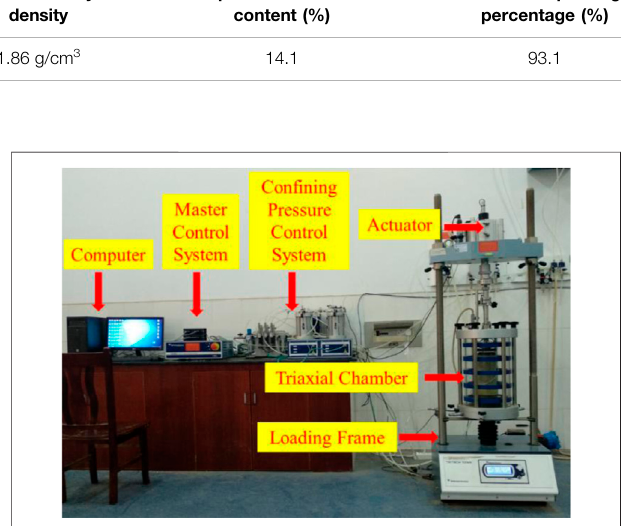
FIGURE 2 | The triaxial loading apparatus of this